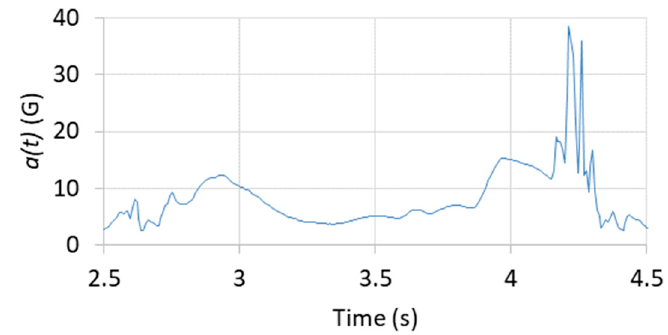
Figure 5. Pattern of one CrossFit athlete.